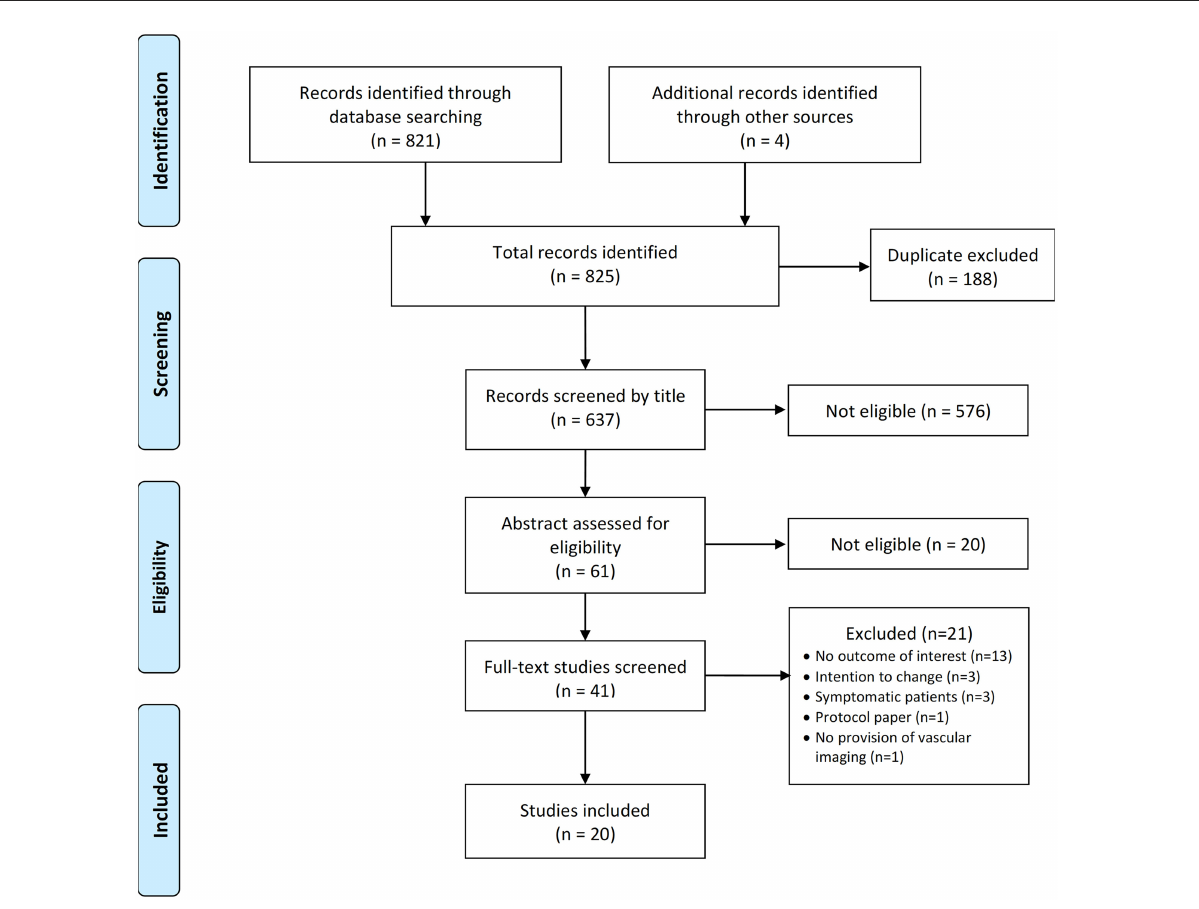
FIGURE1 Flow diagram for the scoping review